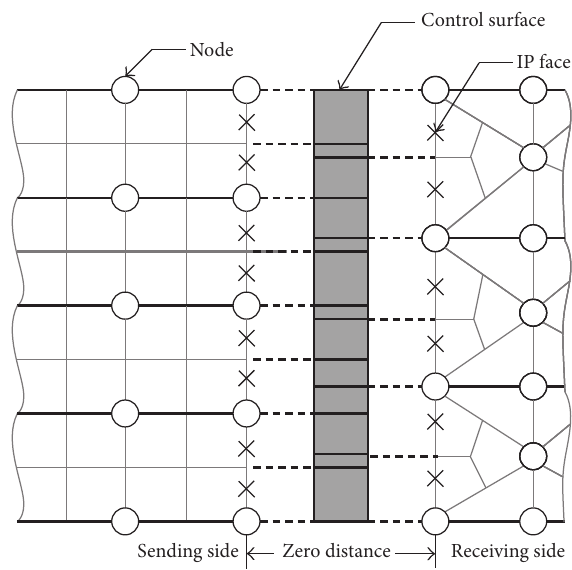
Figure 19: Schematic diagram of the nodes coupling in fluid- structure